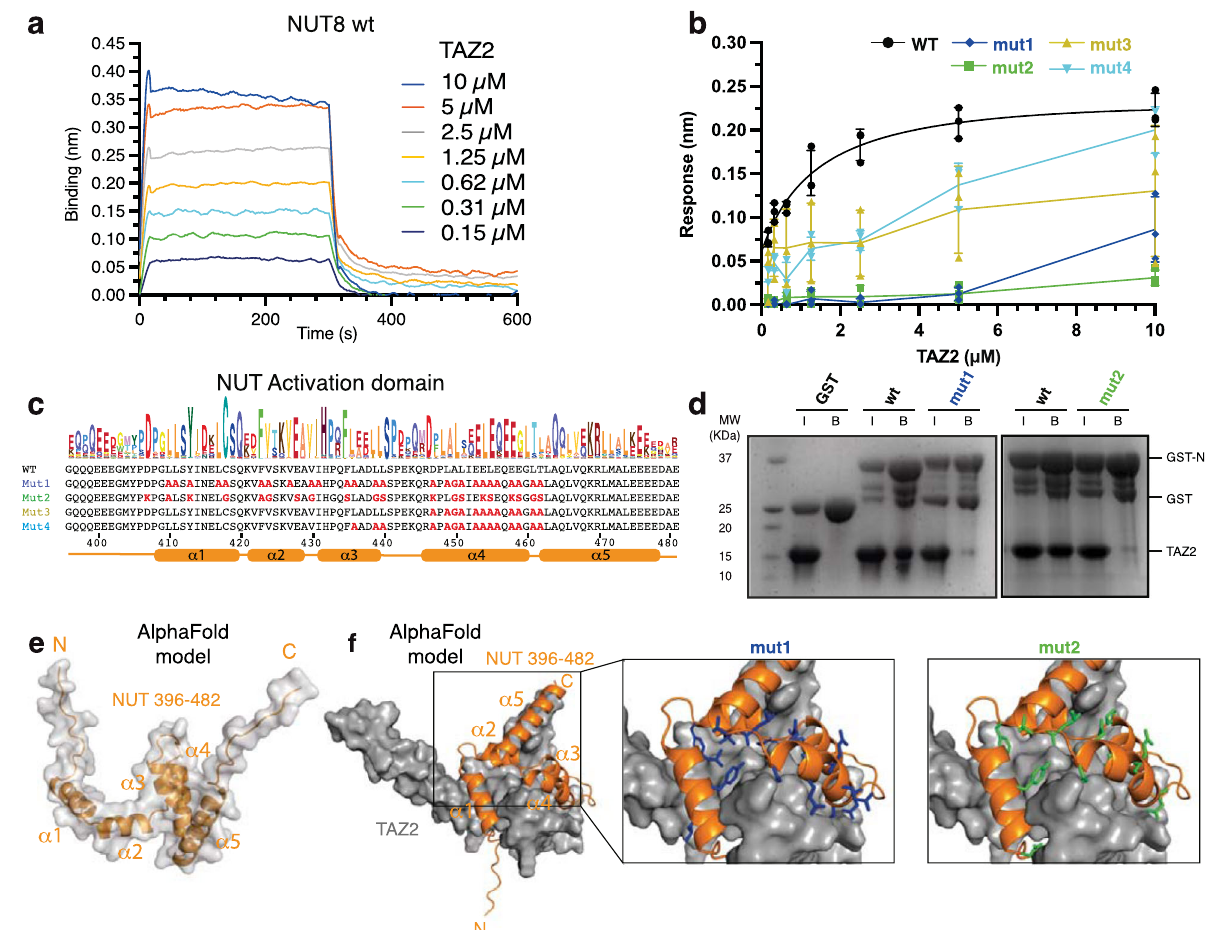
Fig. 3 | Analysis of the TAZ2-NUT interaction. a Representative Biolayer Inter- ferometry (BLI) pro fi les of p300 TAZ2-NUT binding from which the steady-state data were derived. Colours indicate different concentrations of TAZ2 used. b Steady state analysis of p300 TAZ2 interaction with wild-type (black) and NUT mutants using BLI. Data are presented as mean values+/ − SD. N =3 independent technical replicate experiments were done. c Sequences of the NUT AD and